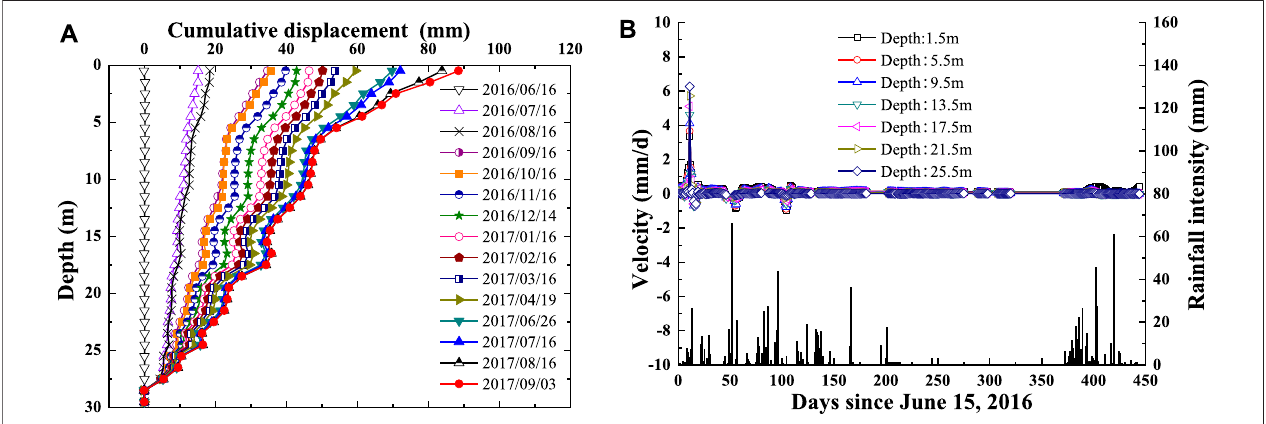
FIGURE 13 | (A) Cumulative displacement and (B) velocities at different depths together with the precipitation data during the period obtained from the real-time monitoring system.